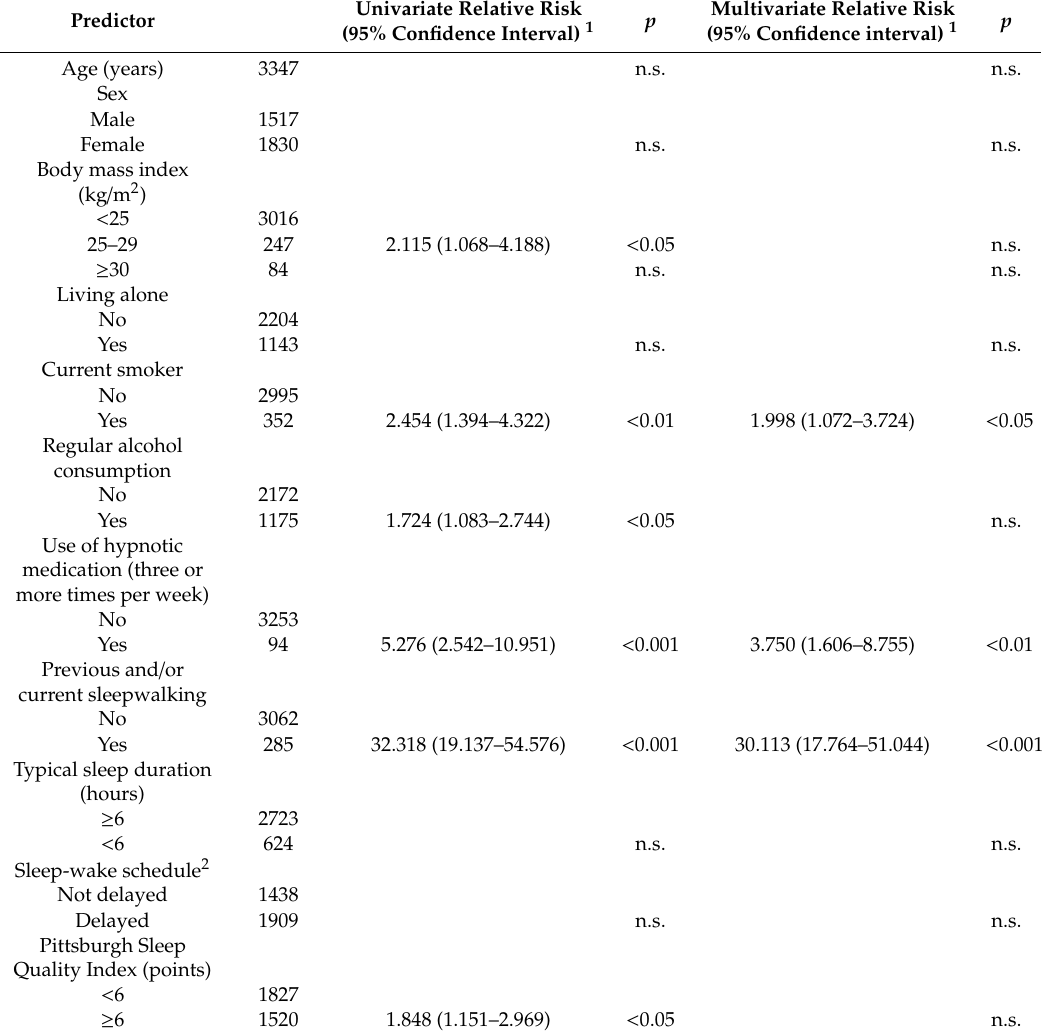
Table 3. Factors associated with sleep-related eating disorder-like behavior one or more times per year.